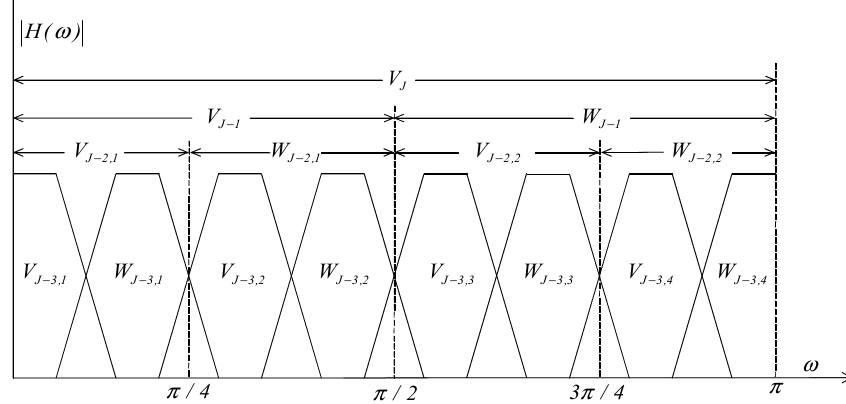
Figure 3. The spectrum characteristics of wavelet packet decomposition.